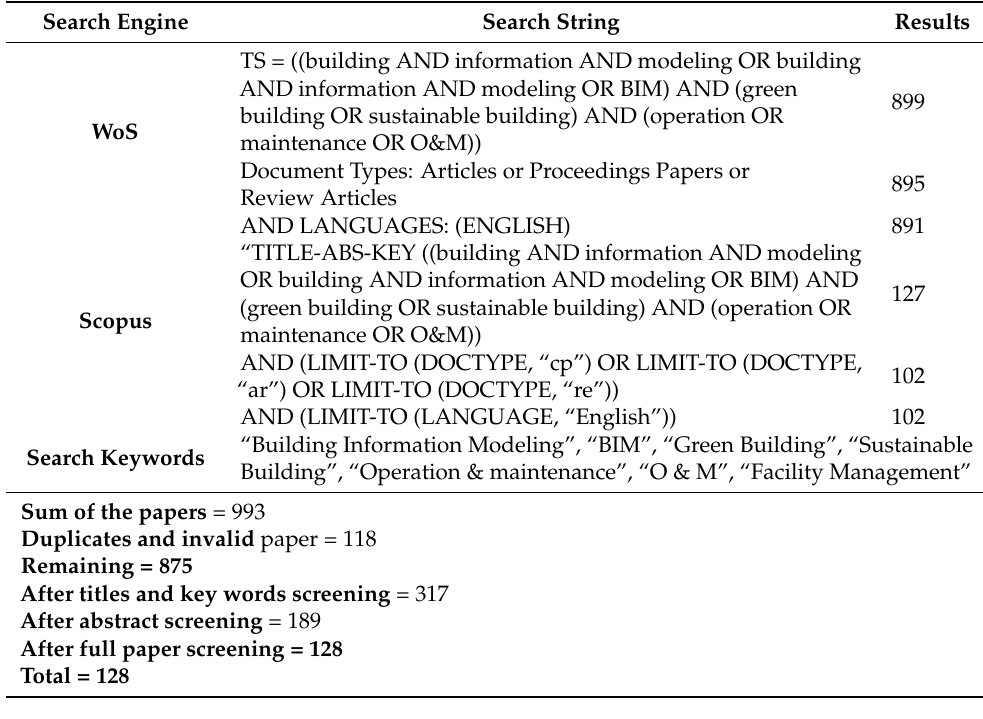
Table 1. The search string and results of the Scopus and WoS databases.